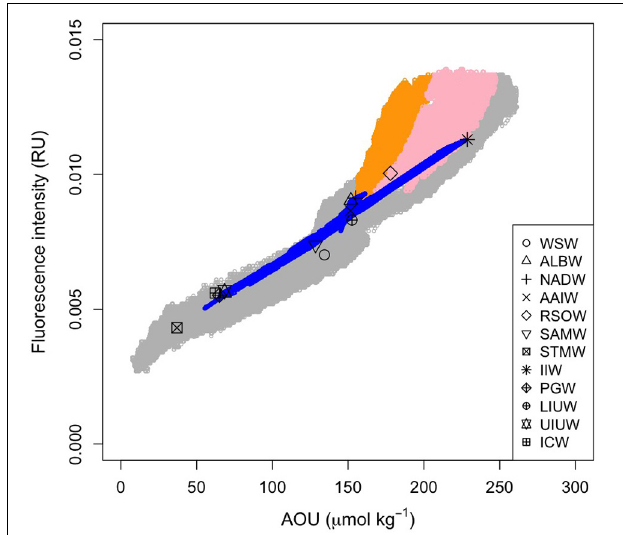
FIGURE 7 | Relationship between FOM and AOU. Open gray and blue circles indicate the measured and archetypal values, respectively. Orange and pink dots indicate the measured data in the density ranges of σ θ > 27.75 and 27.75 > σ θ > 27.5 along the Leg 2 transect, respectively. Symbols are the archetypal values for each of the water